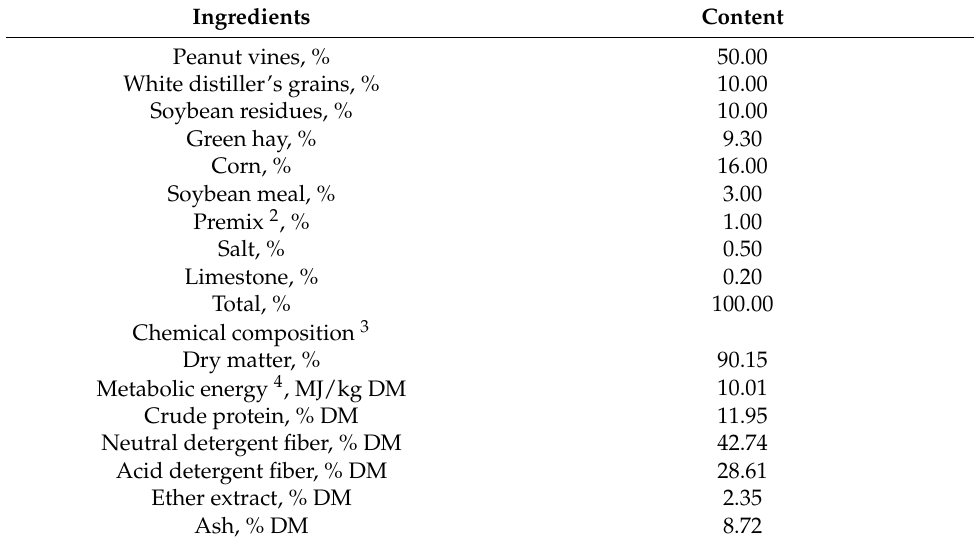
Table 1. Ingredients and nutrient composition of basal diets (DM 1